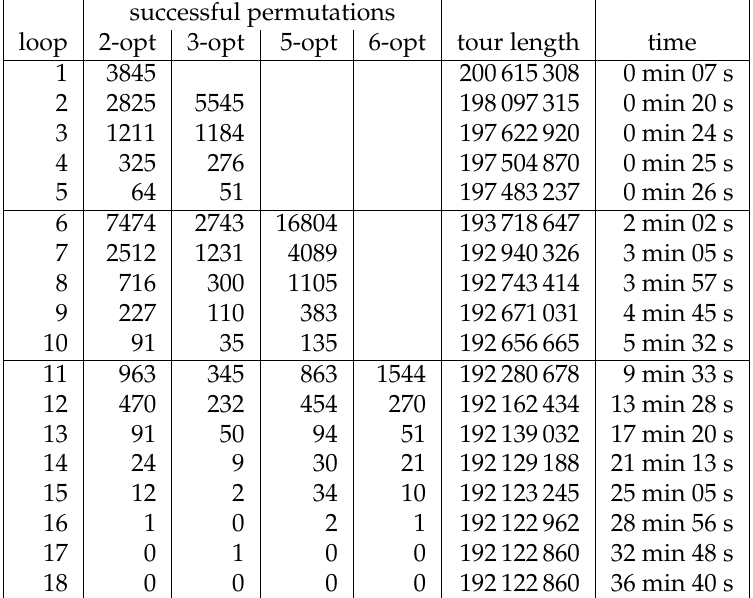
Table 9. Detailed information about the progress with respect to Figure